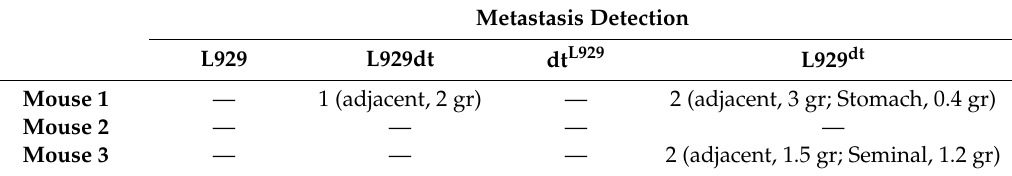
Table 1. Metastasis detection in mice injected in the spleen with 250,000 L929 or L929dt viable cells or with the cybrids L929dt L929 or L929 dt . Groups of 3 mice were injected intraesplenically with 250,000 living cells per mice of the 4 di ff erent cell lines indicated, respectively. The number, localization and weight of the metastasis detected in each mouse is indicated, “-“ means that no metastasis was detected. Metastasis Detection L929 L929dt dt